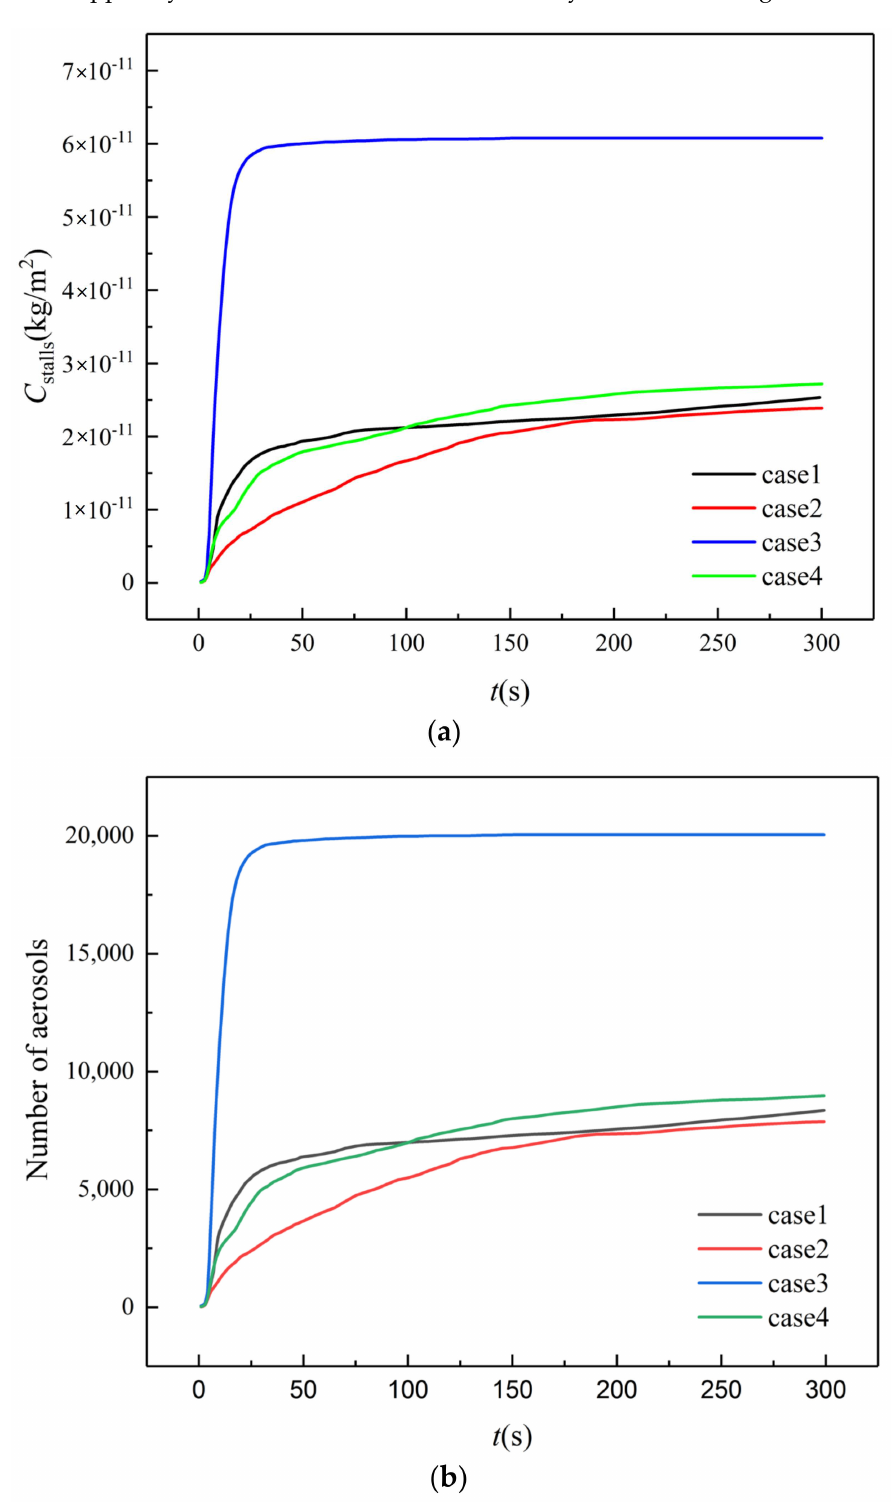
Figure 9. Aerosols deposited on all stall surfaces. ( a ) Cumulative concentration; ( b )